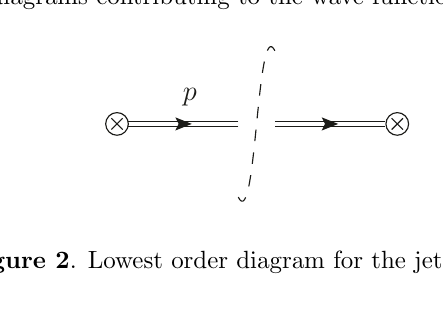
Figure 1 . One-loop diagrams contributing to the wave-function renormalization at O ( (cid:11) s ).